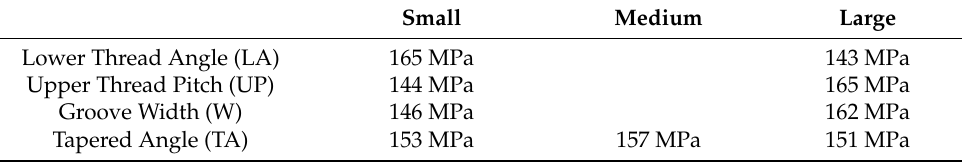
Table 4. Comparison of average stress on anchor of four different design factors in 20 PCF.